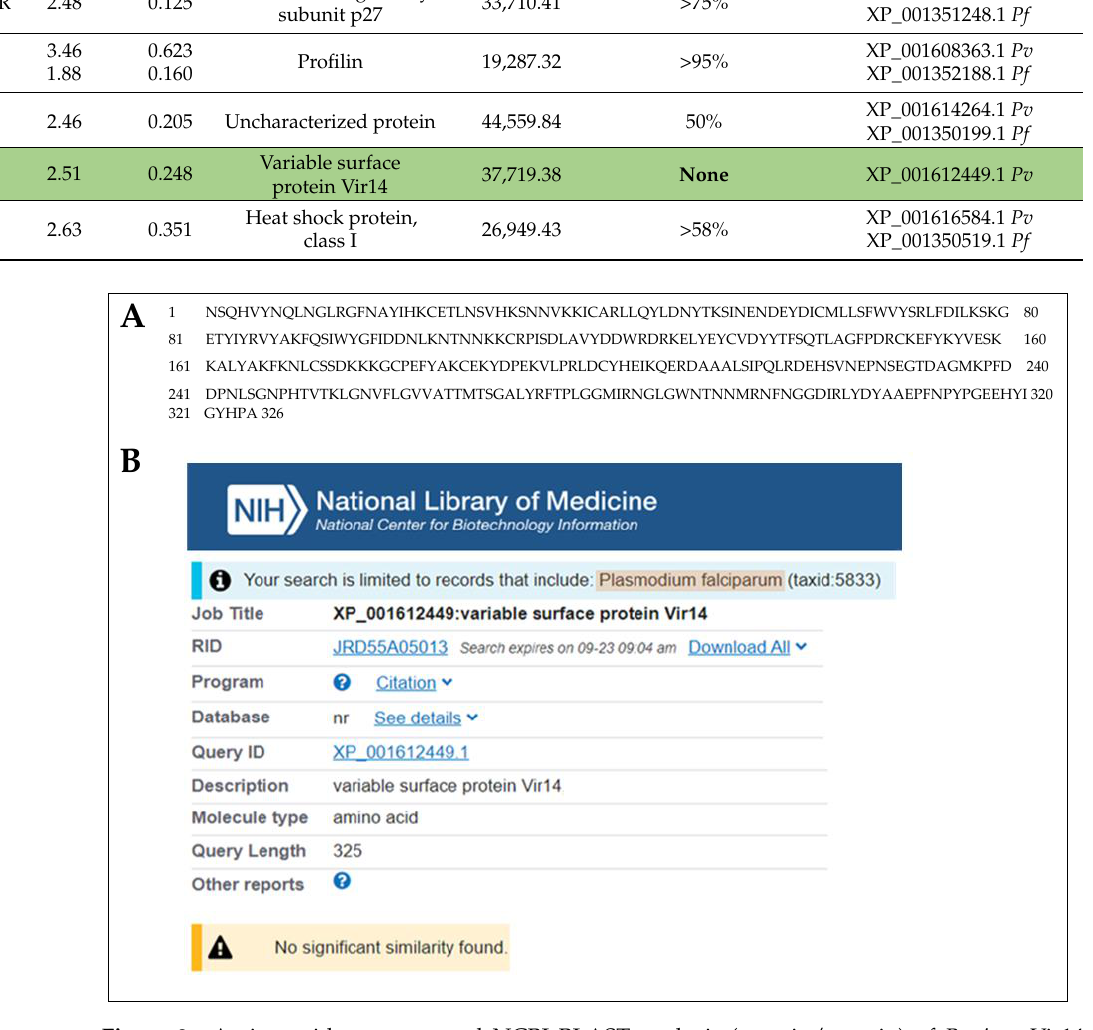
Figure 2. Amino acid sequence and NCBI BLAST analysis (protein/protein) of P. vivax Vir14 (XP_001612449.1). The BLAST analysis of the full-length protein sequence ( A ) revealed that the Vir14 protein is unique to P. vivax and that it has no significant similarity with any proteins of P. falciparum proteins ( B ), proteins of other Plasmodium species (not shown) or with human proteins (not shown).